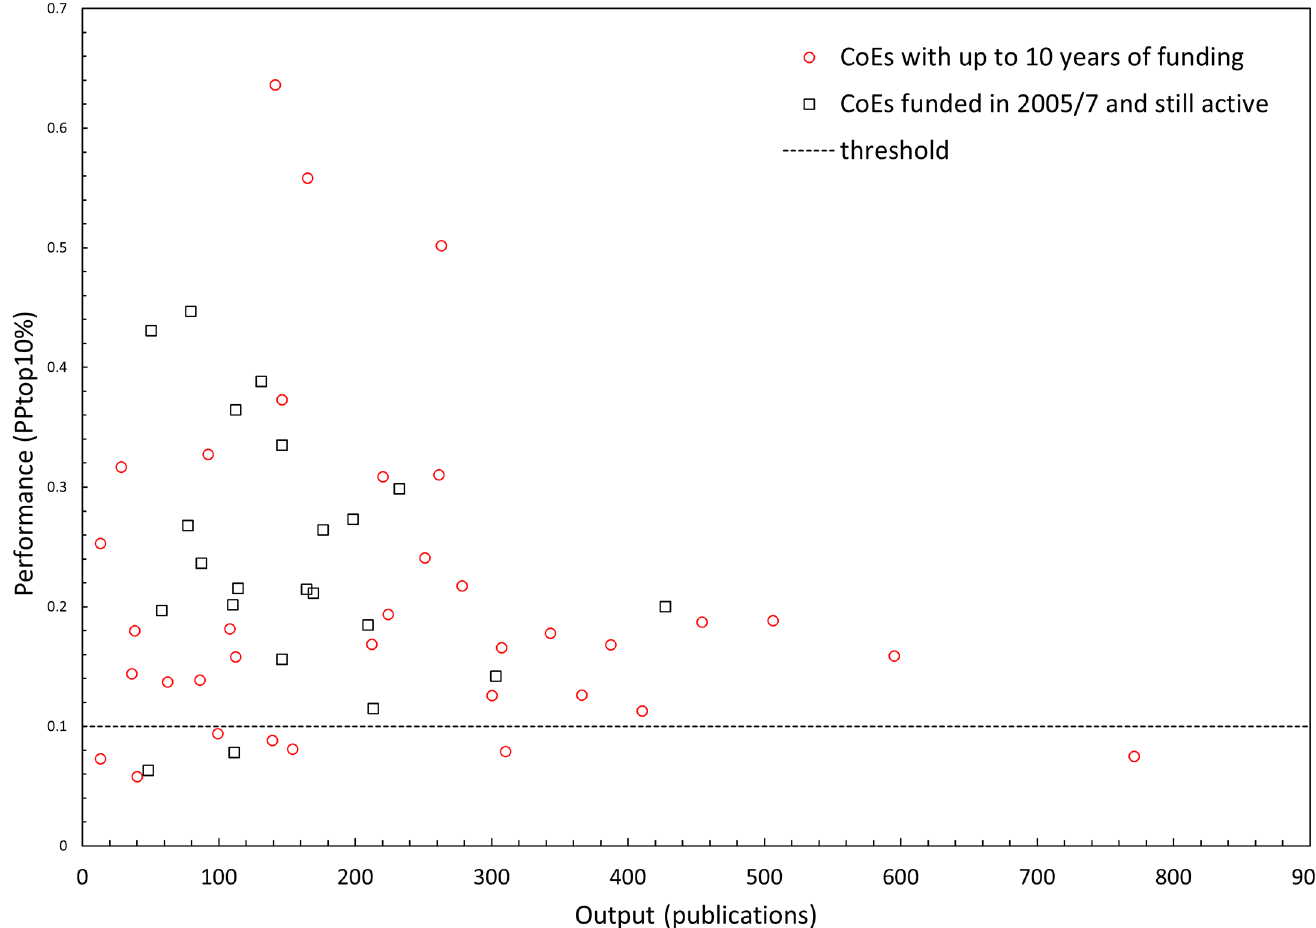
Fig 1. Performance variation of 57 CoE included in the bibliometric analyses of publications linked to the DNRF in the period 1993 to 2011. Circles indicate CoEs with full or terminated funding period at the time of the bibliometric analyses (i.e., 2013), and square indicate still active CoEs. Performance is measured with the PPtop10% indicator developed by CWTS, Leiden University, the Netherlands, and it measures the proportion of papers from a CoE that are among the 10% most cited in the Web of Science citation database; the expected proportion is 10% indicated with the dotted line.